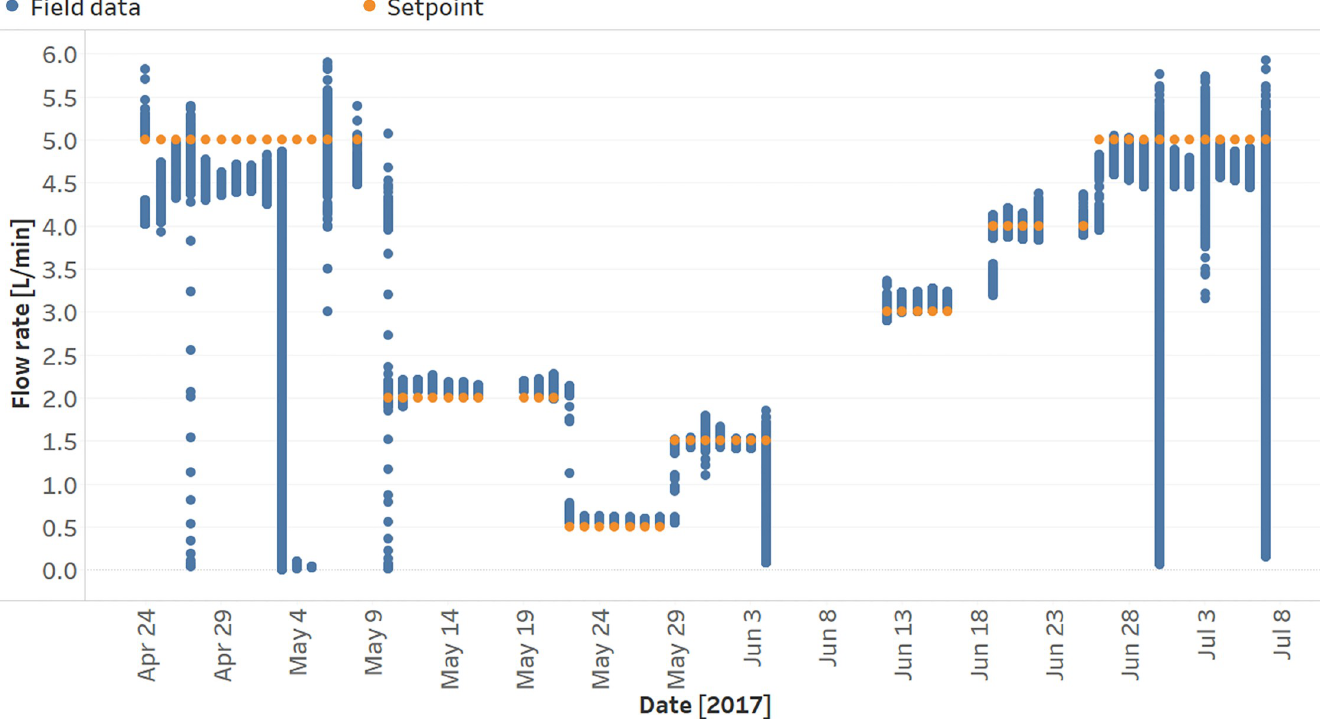
Fig 4. Actual and set point flow rates over the study